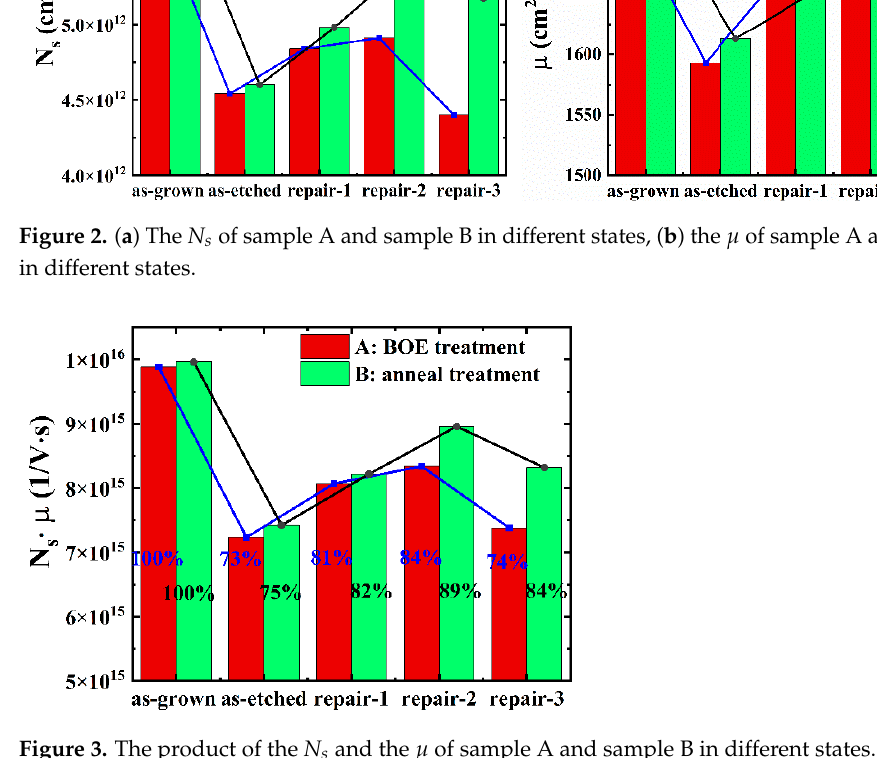
Figure 3. The product of the N s and the μ of sample A and sample B in different states.